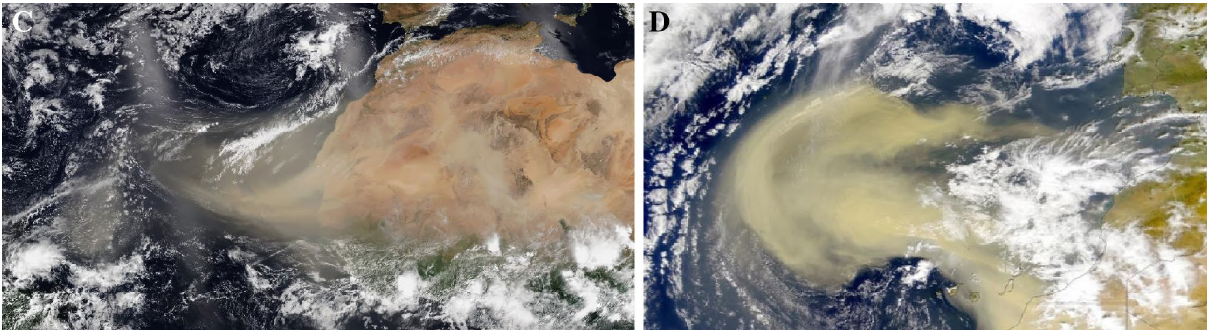
Fig. 2 True-color image of dust ( c ) and image enhancement ( d ) 2012 June 19